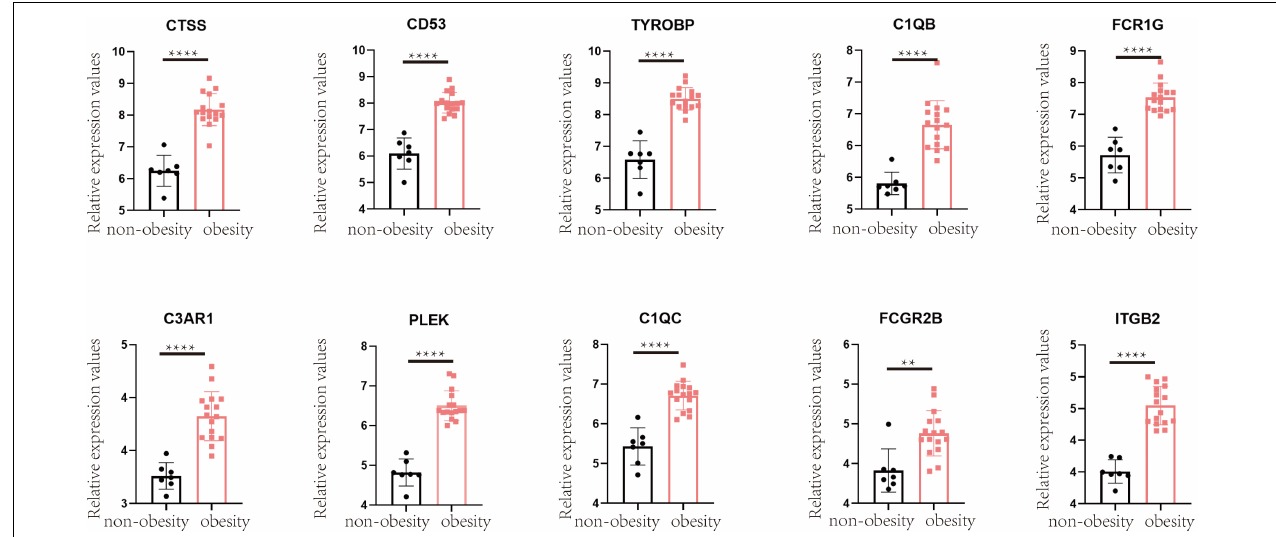
FIGURE 7 | Verification in GSE55200 dataset, the comparison of hub gene in adipose tissue of obese and non-obese population. Y -axis represents the relative expression counts of genes. Obesity was marked in red, non-obesity was marked in black. ** for < 0.01, **** for <